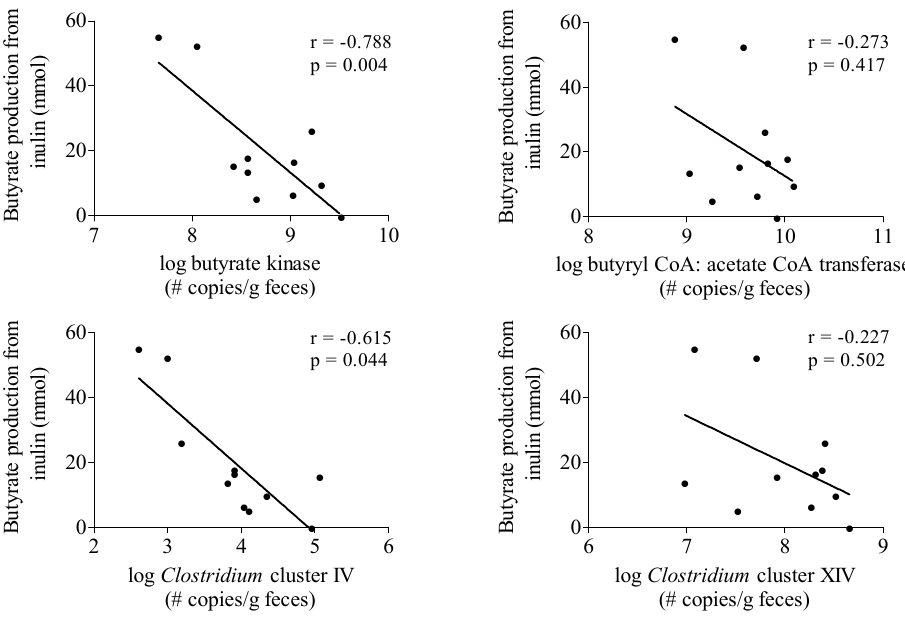
Figure 3. Correlation between butyrate production from inulin and parameters of butyrate producing capacity. n = 11, one subject was not able to deliver a sample.